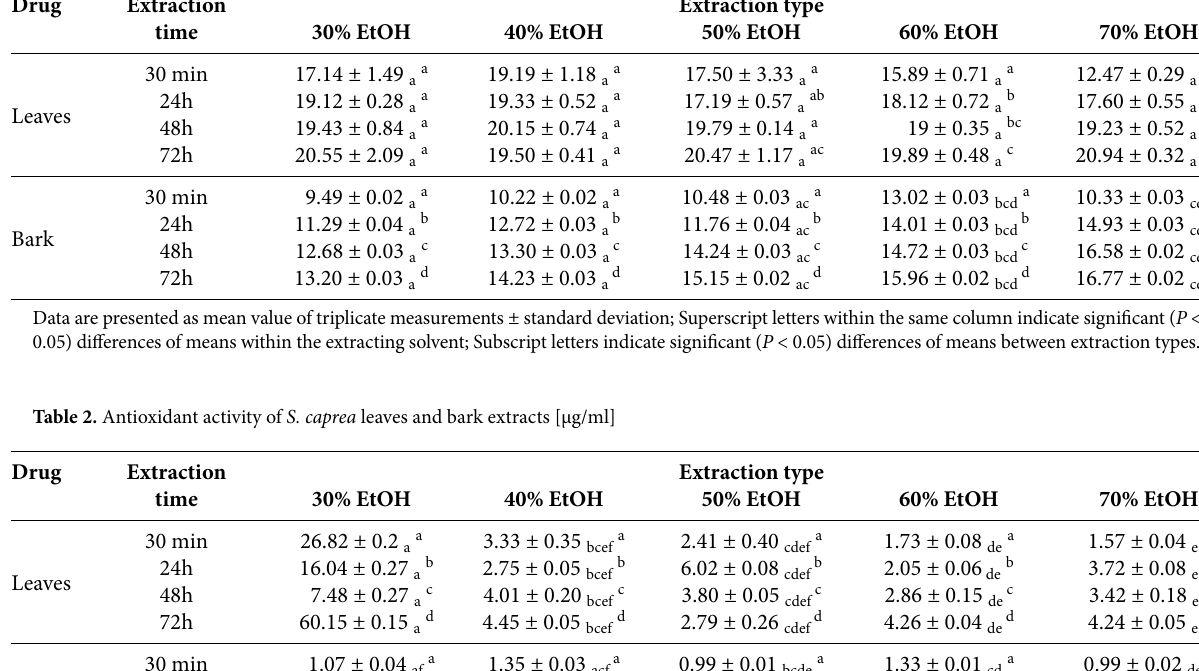
Table 1. Effects of extraction solvent on extraction yield (g dry extract /100 g drug) of leaves and bark of Salix caprea Drug Extraction